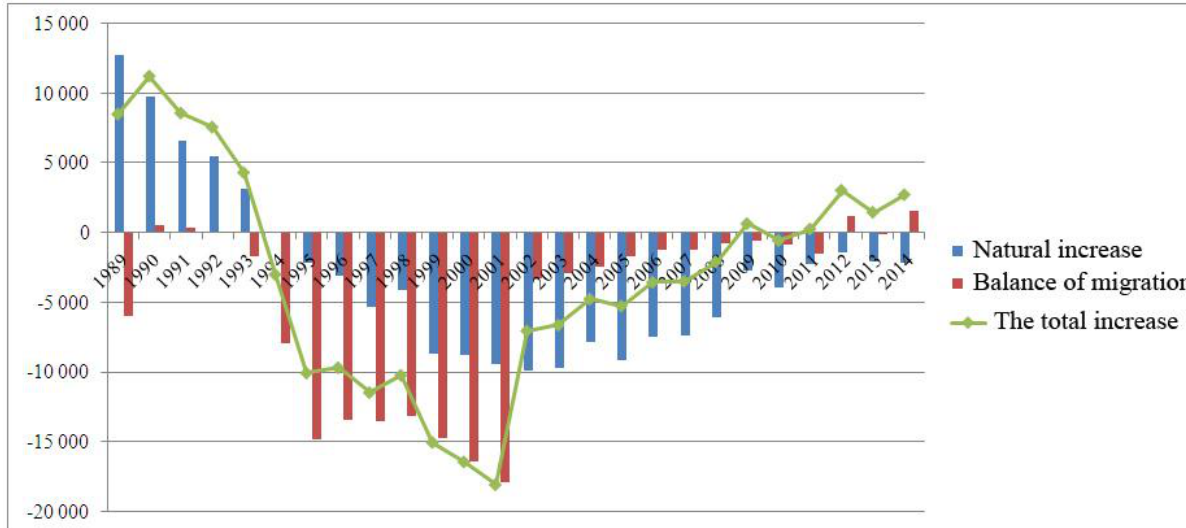
Fig. 1. Dynamics of natural and migration movement of the population in Lviv Region for the period of 1989-2014. It is processed on the basis of the data from Main Department of Statistics of Lviv